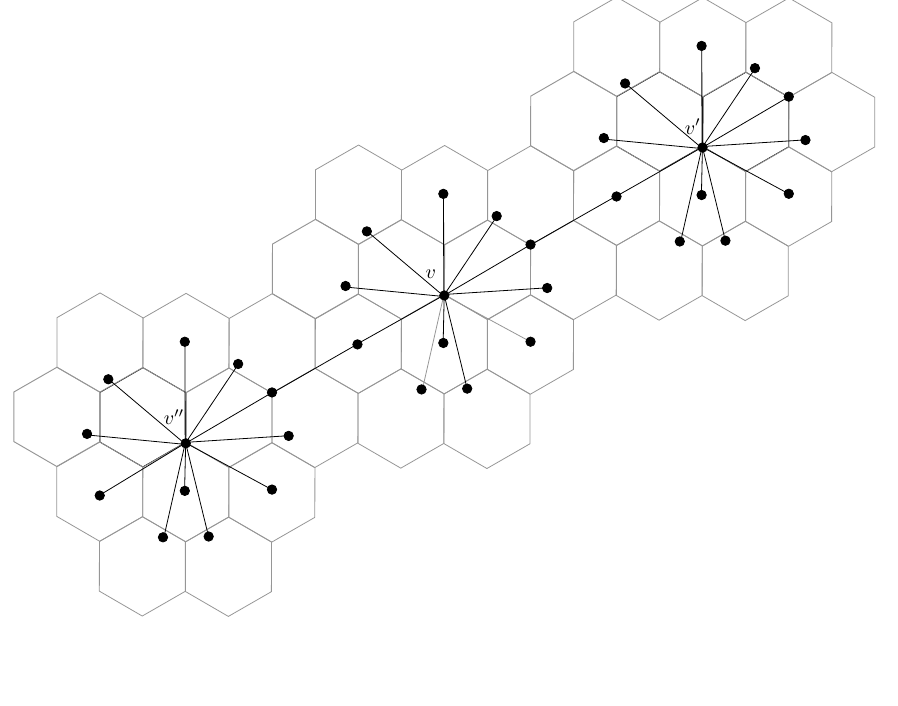
Figure 5 . The enlargement of our construction of the tight example. It is possible to extend this to an arbitrarily large